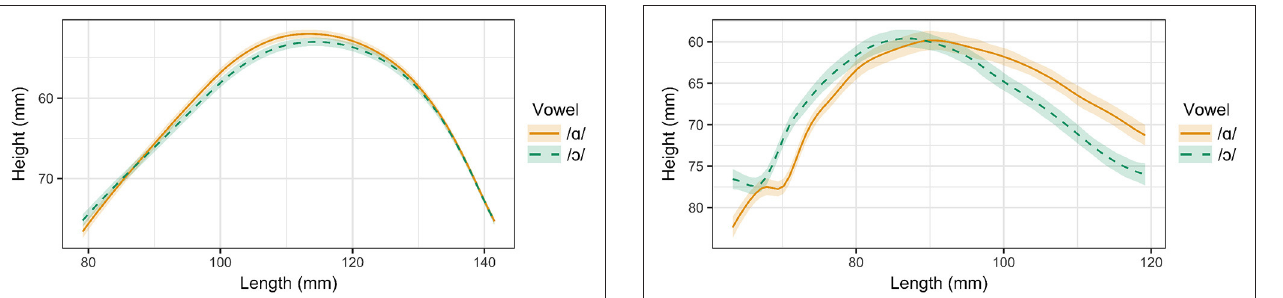
FIGURE 5 | Main effect curves for SSANOVA model of /A/ and /O/ for Speaker 4. Shading indicates 95% Bayesian confidence interval.